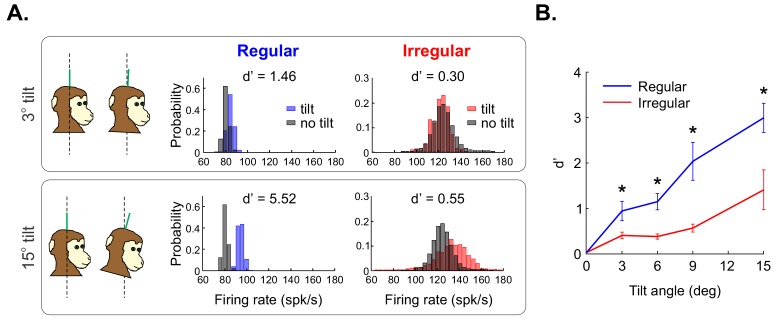
Regular otolith afferents better discriminate between different head orientations relative to gravity than do their irregular counterparts.(A) (Top left) schematic showing the head positioned vertically (i.e., 0o, left) and at a 3o angle relative to gravity (right). (Top center) Firing rate distributions from an example regular afferent when the head is positioned at 0o (black) and at 3o (blue). (Top right) Firing rate distributions from an example irregular afferent when the head is positioned at 0o (black) and at 3o (red). Also shown are the values of discriminability d’. (Bottom) Same as top row but with a head position at a 15o angle relative to gravity. Firing rates were obtained by convolving the spike trains with a Gaussian spike-density function with standard deviation 10 ms. Firing-rate distributions were obtained using a binwidth of 4 spk/sec (as detailed in the 'Materials and methods'). (B) Population-averaged discriminability index d’ values for regular (blue) and irregular (red) otolith afferents as a function of head orientation angle. '*' indicates statistical significance at the p=0.05 level using a Wilcoxon ranksum test.